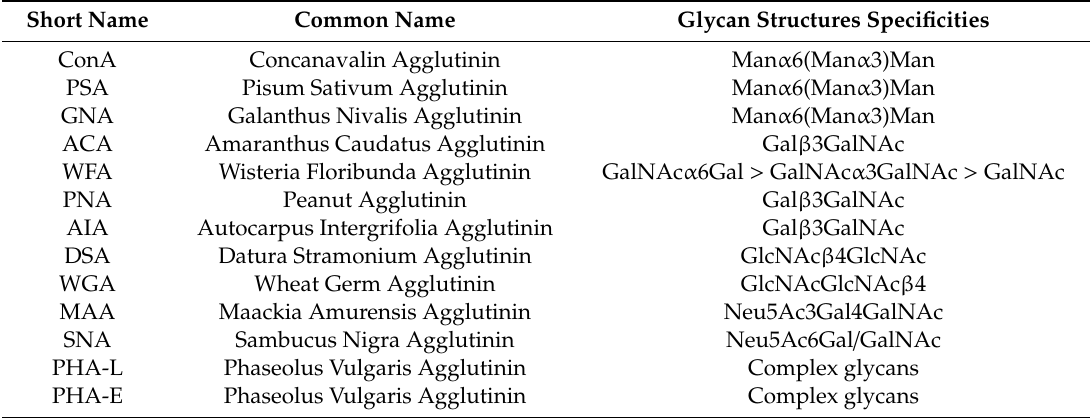
Table 1. Lectins